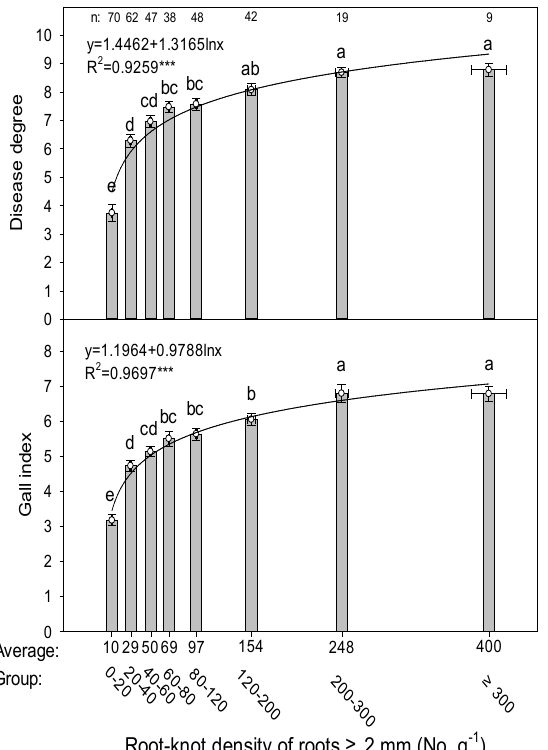
Figure 7. Average root-knot density of roots with a root diameter ≥ 2 mm and their relationship with the average disease degree and gall index in corrected groups based on RKD reclassification. Different lowercase letters represent significant difference at p = 0.05. Significant level: ***, p < 0.001.